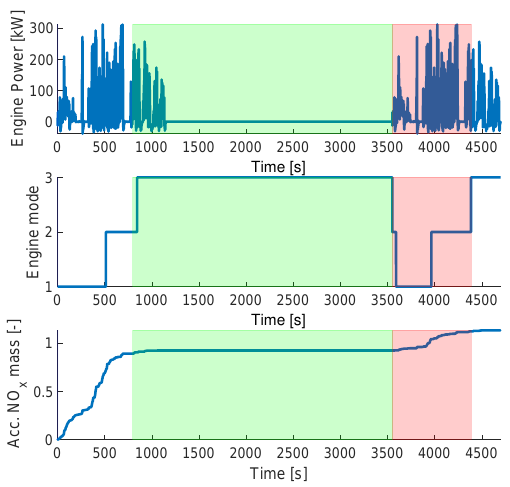
Figure 6. Illustration of the phases in an event. The pre-heating phase is marked with green and the pollution phase is marked with red. The engine mode and accumulated NO x mass is that of the baseline